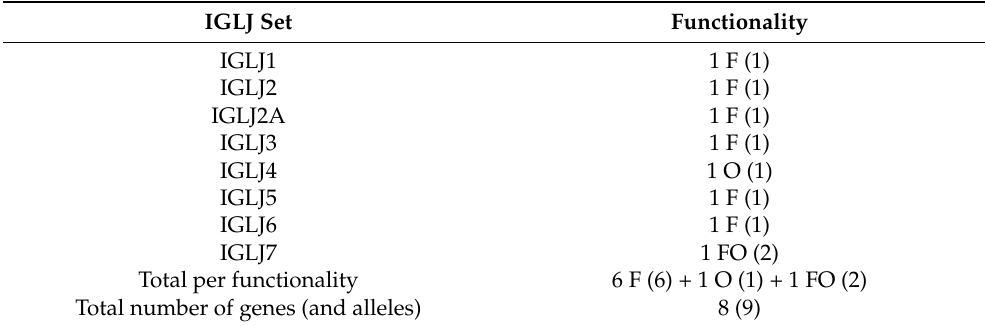
Table 9. For each IGLJ set, number of IGLJ genes per functionality and, between parentheses, number of alleles are shown.